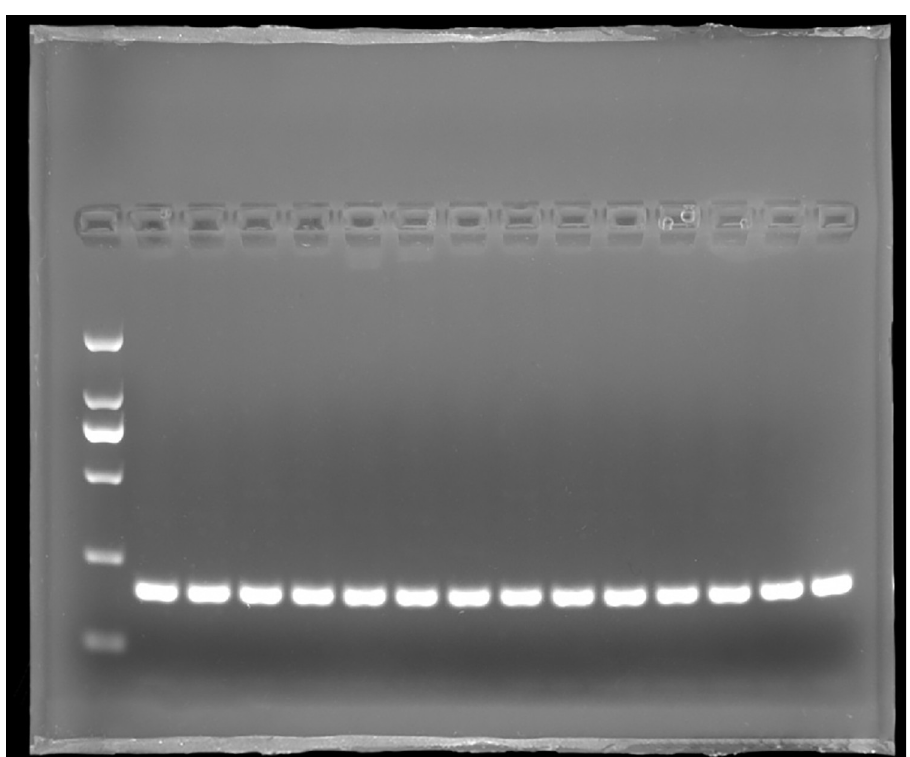
Fig 5. PCR amplification of BMPRIB Gene. M: DNA standard DL 2000; 1–14: Amplification product of the BMPRIB gene.